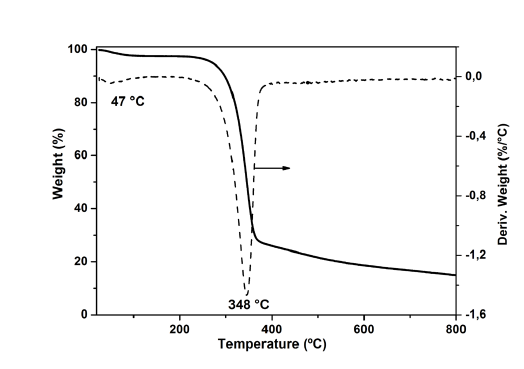
Figure 1. Thermogravimetric analysis of the cotton fiber.